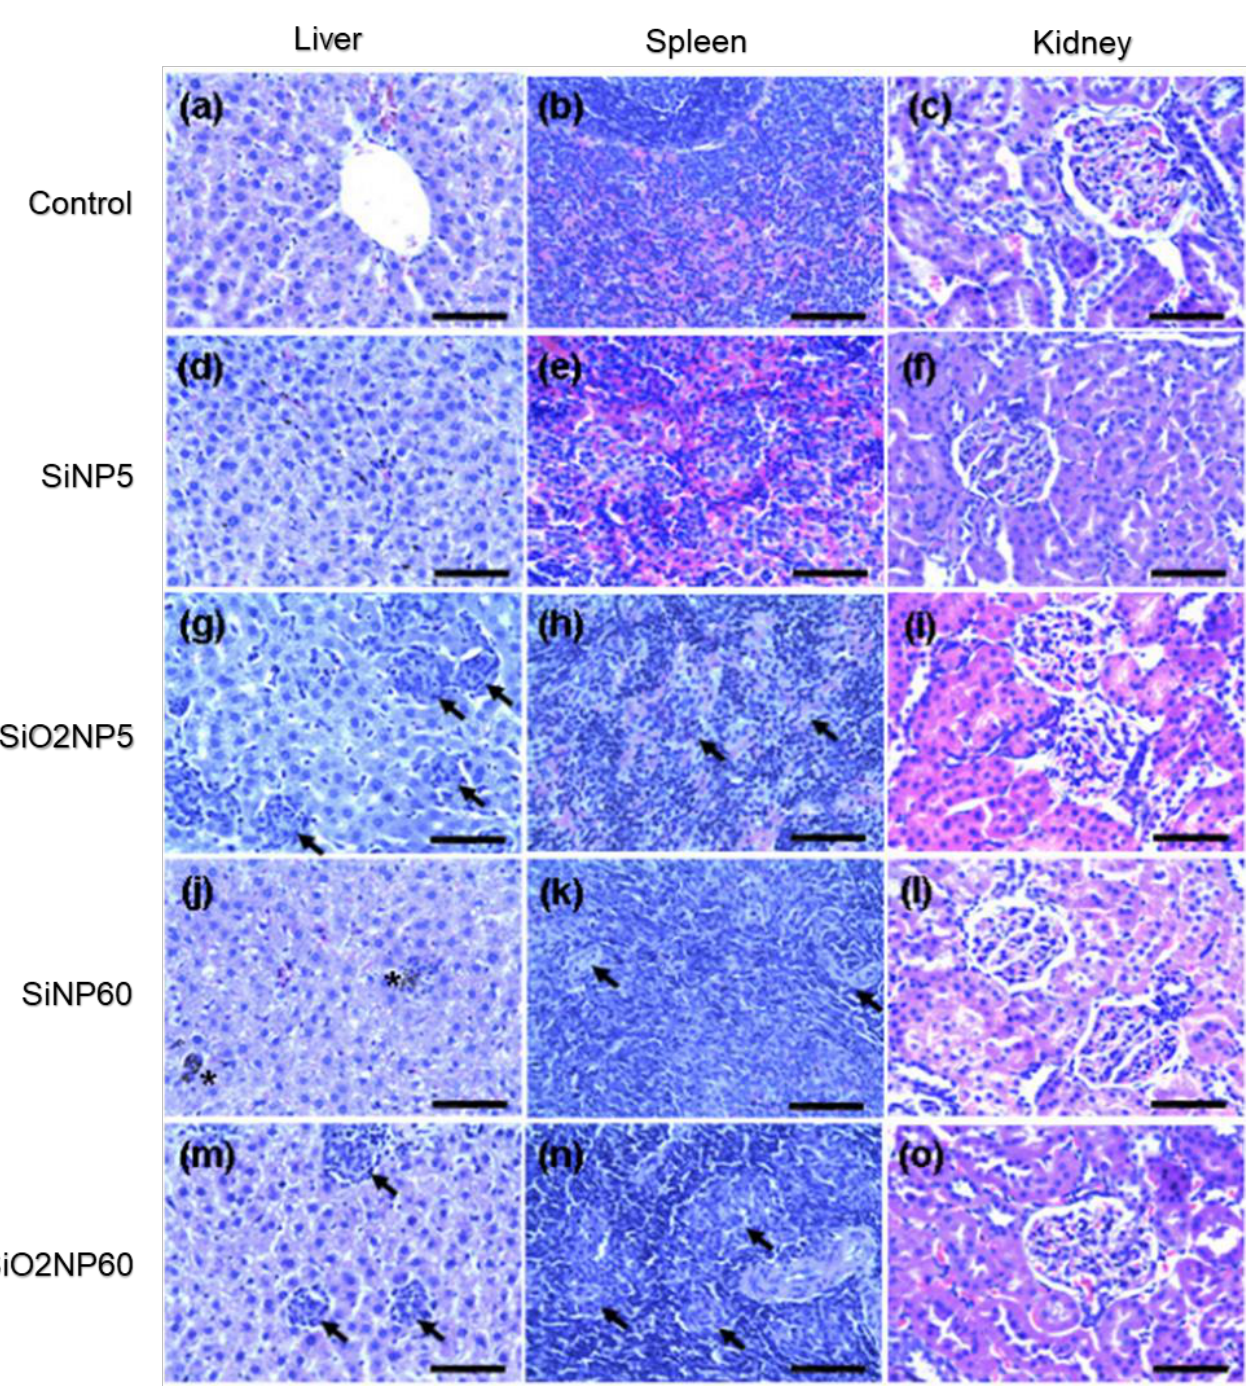
Figure 1. Histological evaluation of organs from rats treated with SiNPs or SiO2NPs. Liver, spleen, and kidney samples were collected at 5 and 60 days after intravenous administration of SiNPs or SiO2NPs at a dose of 7 mg/kg and fixed with paraformaldehyde, followed by staining with hematoxylin and eosin. ( a – c ) Vehicle-treated animals (controls); ( d – f ) 5 days after SiNP treatment (SiNP5); ( g – i ) 5 days after SiO2NP treatment (SiO2NP5); ( j – l ) 60 days after SiNP treatment (SiNP60); and ( m – o ) 60 days after SiO2NP treatment (SiO2NP60). The arrows indicate granulomas in the liver and spleen. The asterisks indicate microgranulation in the liver. The tissue sections were observed under a microscope at 4 00×. The scale bar is 25 μm for all images. The pictures are representative of at least four independent sections [42].